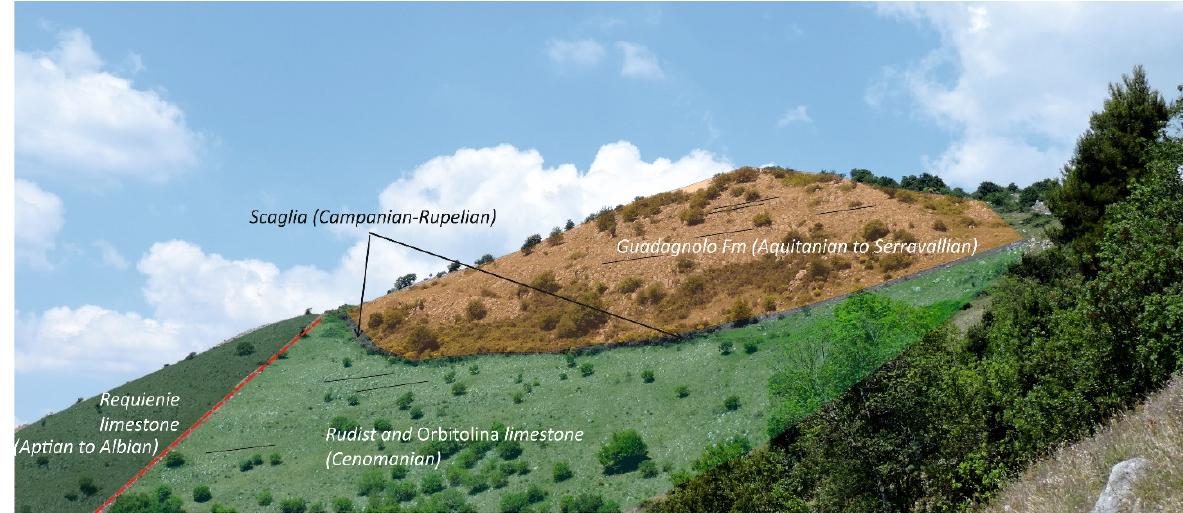
Figure 8. Panoramic view of Punta S. Egidio showing Scaglia Fm paraconformably resting on top of the Cretaceous carbonate platform.